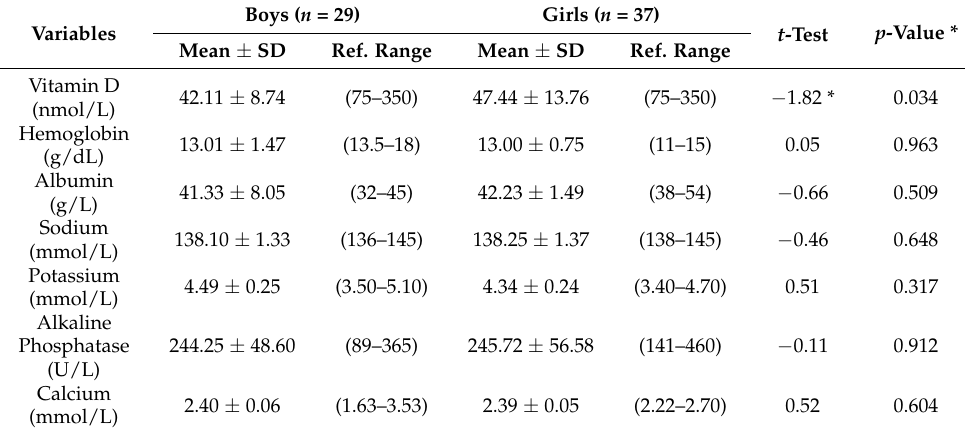
Table 5. Biochemical parameters in relation to reference range for children ( n = 66) with CD following the Ministry of Health GFD